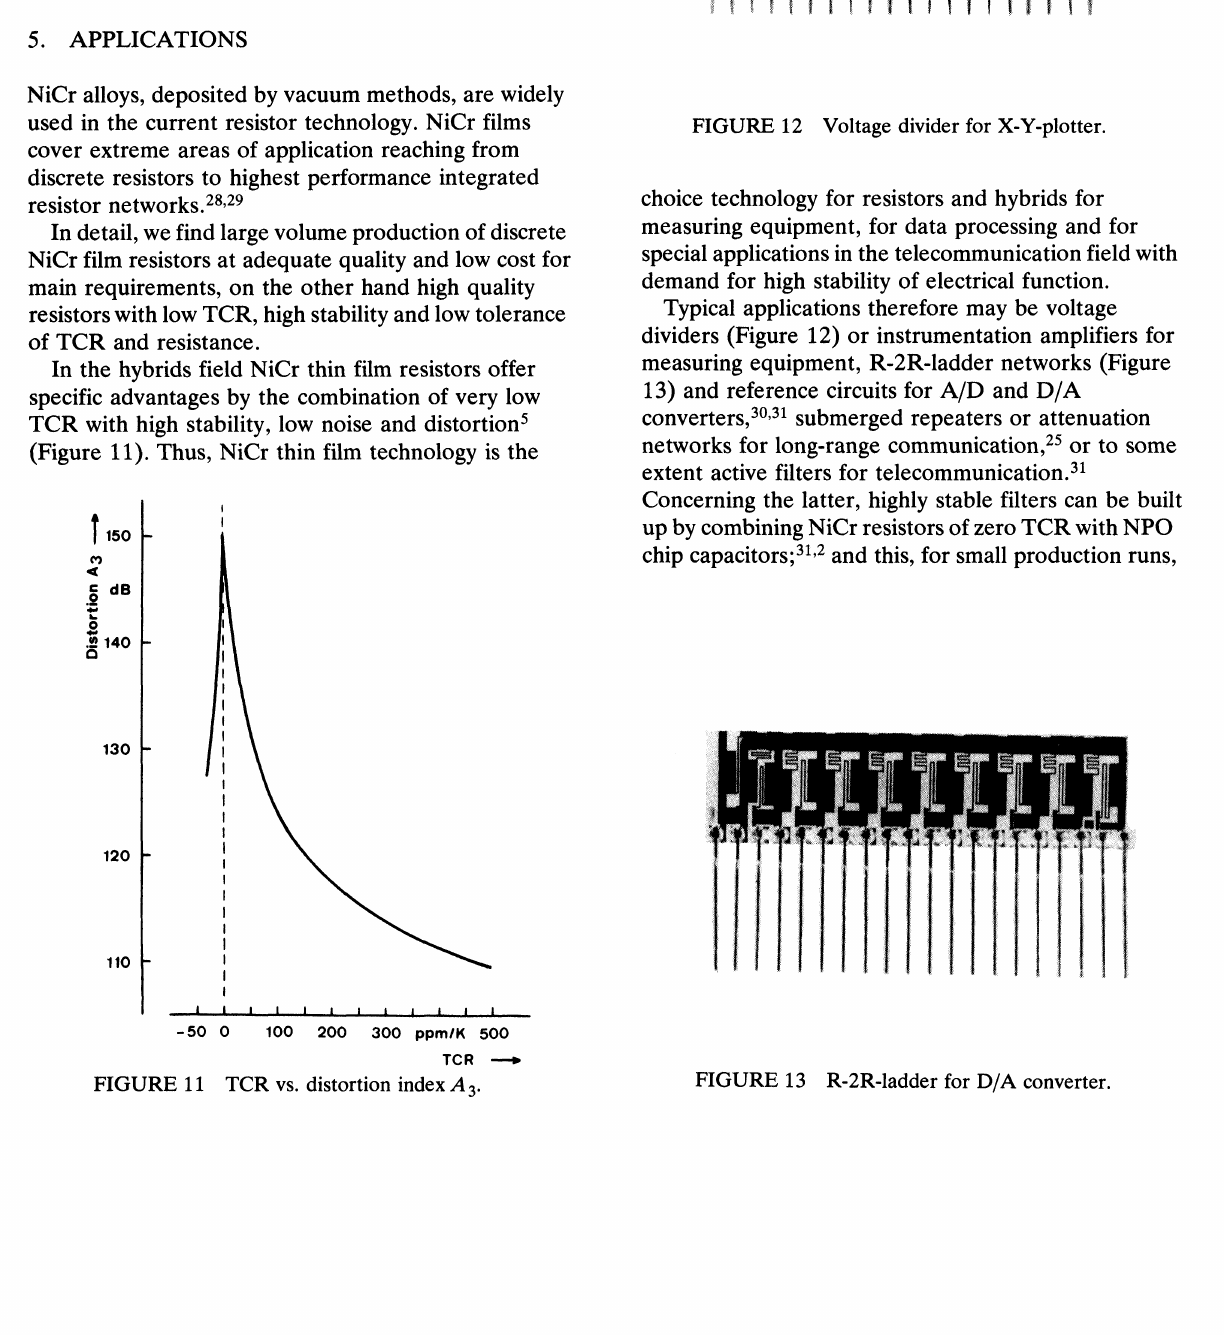
FIGURE 13 R-2R-ladder for D/A